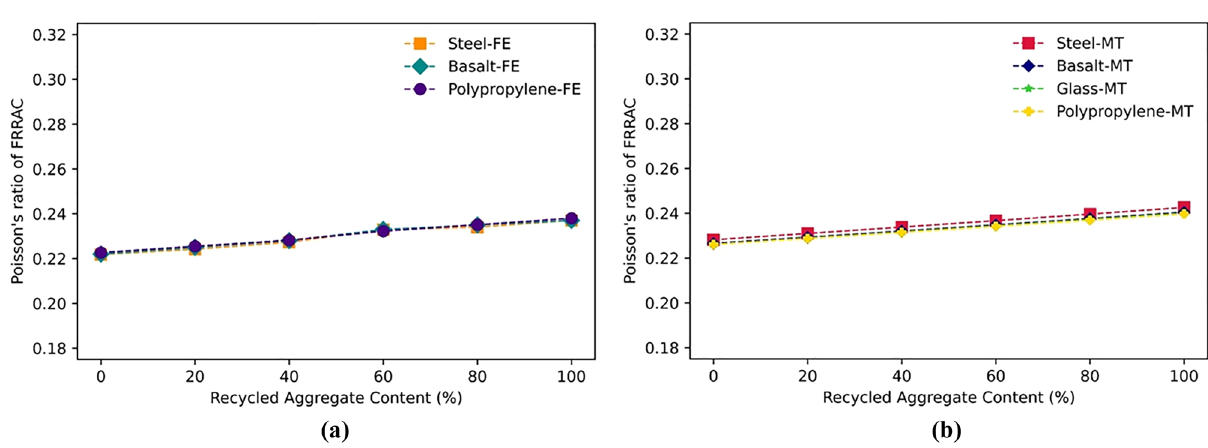
Figure 14. The Poisson’s ratio of FRRAC based on RA content: ( a ) FE approach, ( b ) MT